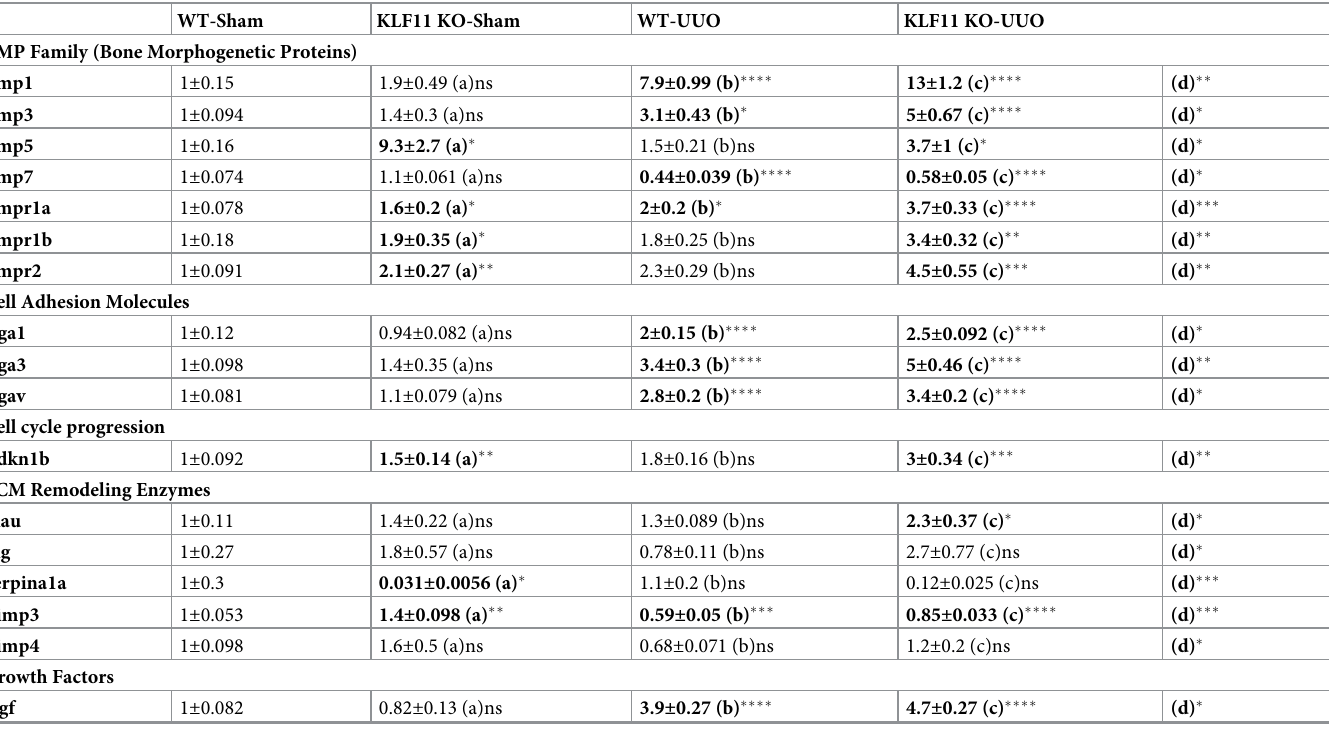
Table 1. Differentially expressed genes in the TGF- β /BMP pathway and fibrotic response in Sham mice compared to UUO mice. WT-Sham KLF11 KO-Sham WT-UUO KLF11